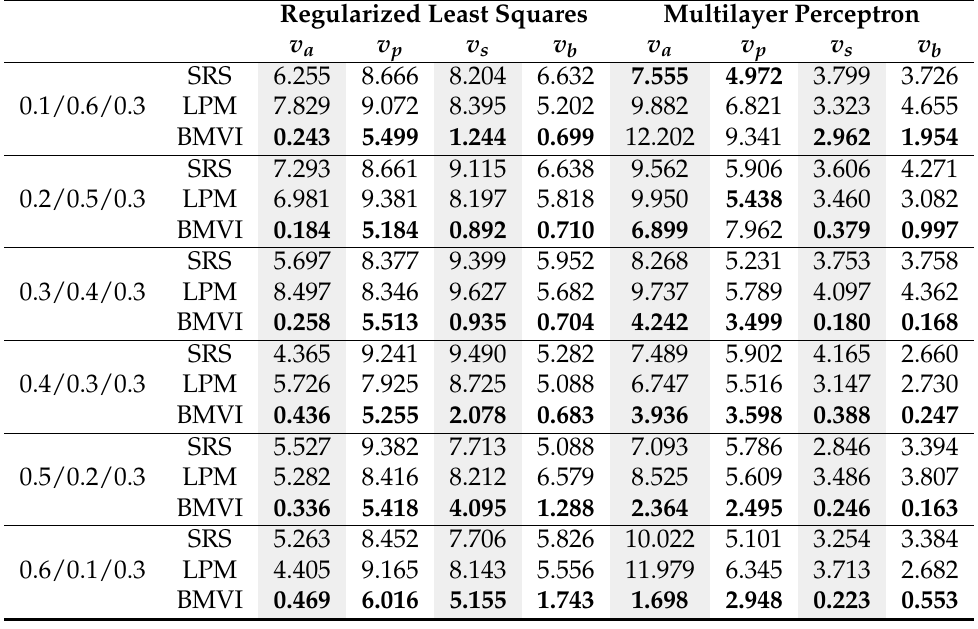
Table 3. Analogous results as in Table 2 but for population variance σ 2 estimations. All the values in table below have a common factor of 10 5 which has been omitted from the values for clearer presentation. The response variables for volume of growing stock (all trees, pine trees, spruce trees, broadleaf trees) are denoted as v a , v p , v s and v b respectively.